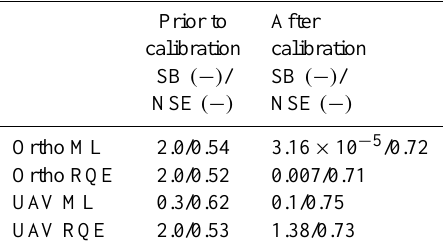
Table 2. Goodness-of-fit measures prior to and after calibration (both quantified for the validation